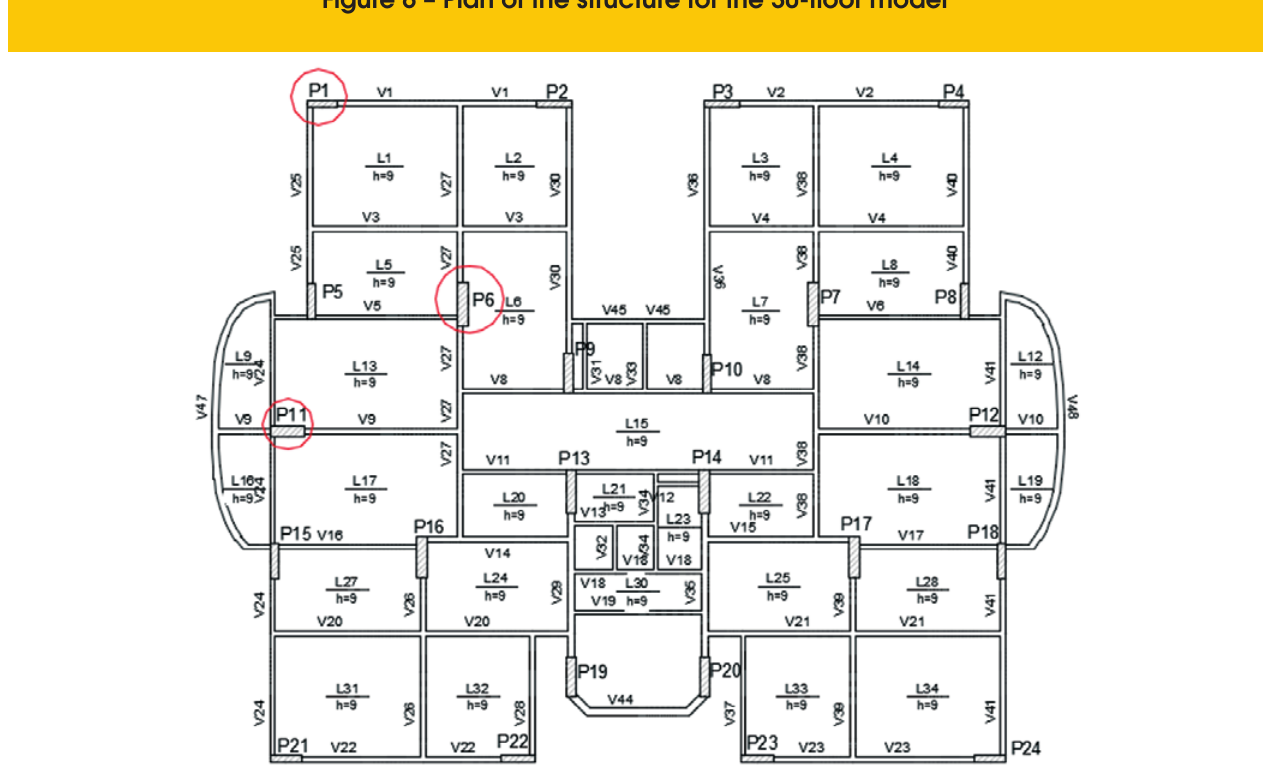
Figure 6 – Plan of the structure for the 30-floor